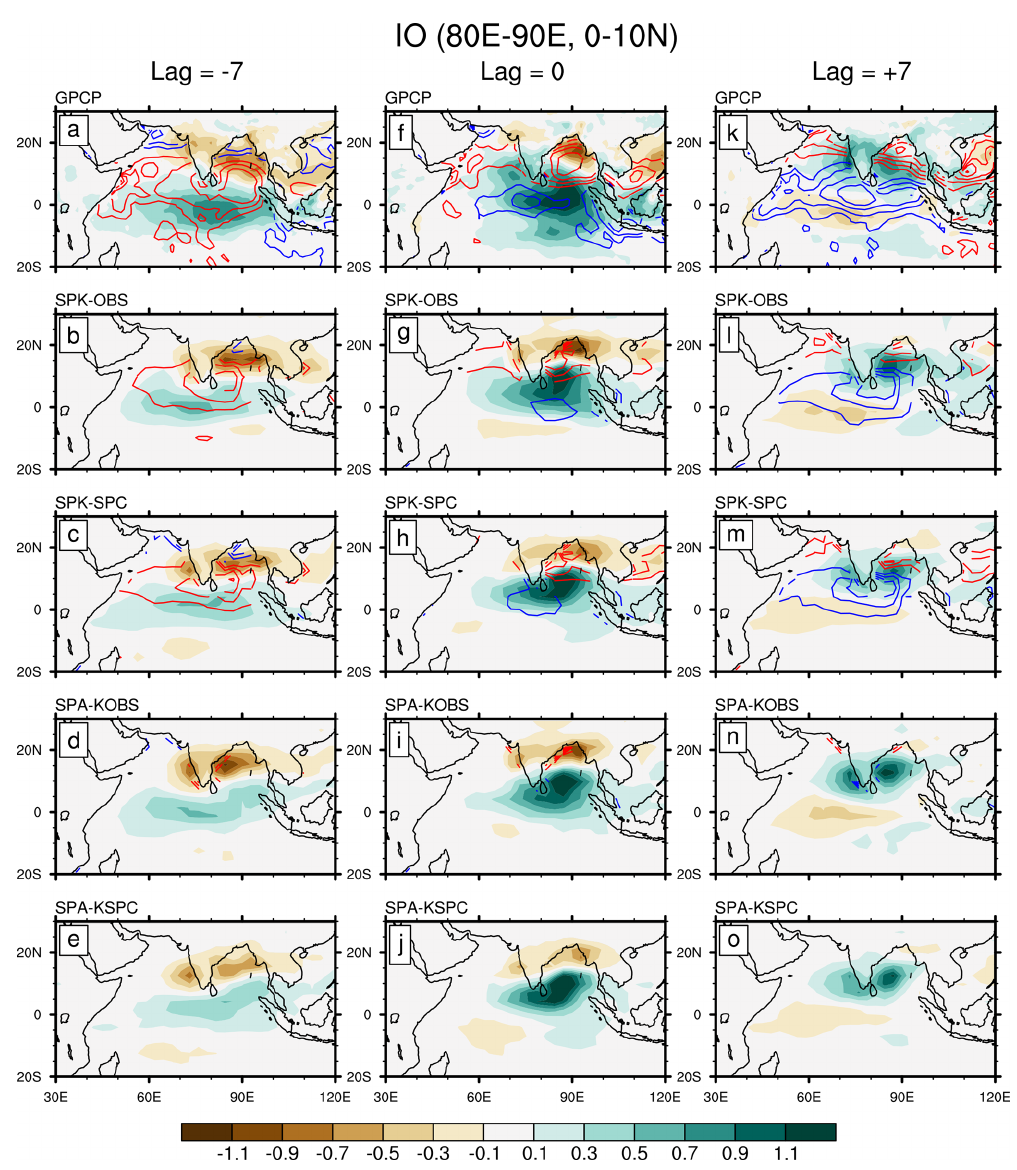
Figure 6. Regression coefficients of intraseasonal precipitation (shading; mmd − 1 (mmd − 1 ) − 1 ) and SST (contour; ◦ C(mmd − 1 ) − 1 ) onto (0–10 ◦ N, 80–90 ◦ E) averaged intraseasonal precipitation over the Indian Ocean at lags of (a–e) − 7, (f–j) 0, and (k–o) + 7d, for (a, f, k) GPCP precipitation and ERAI SST, (b, g, l) SPK-OBS, (c, h, m) SPK-SPC, (d, i, n) SPA-KOBS, and (e, j, o) SPA-KSPC. The contour interval is 0.01 ◦ C(mmd − 1 ) − 1 ; positive (negative) values are represented by red (blue)